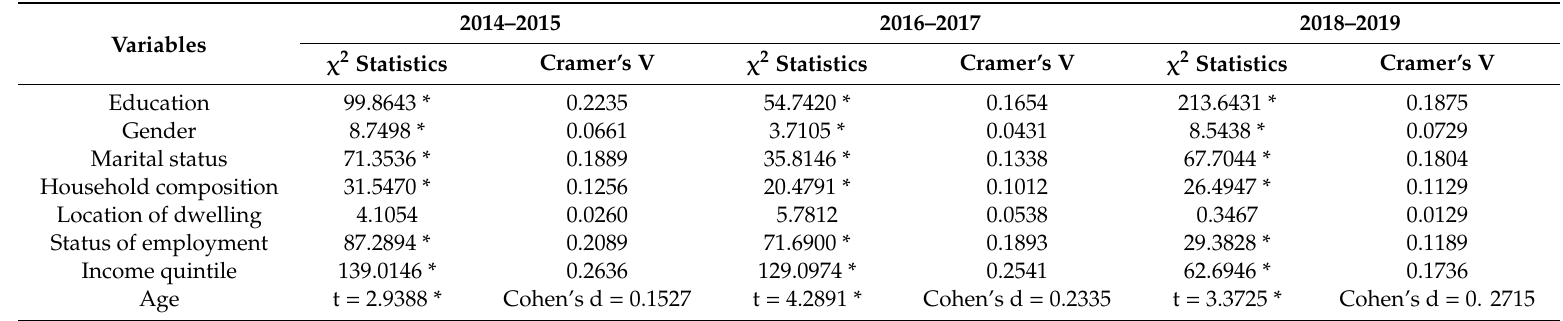
Table 3. Association between food insecurity and respondents